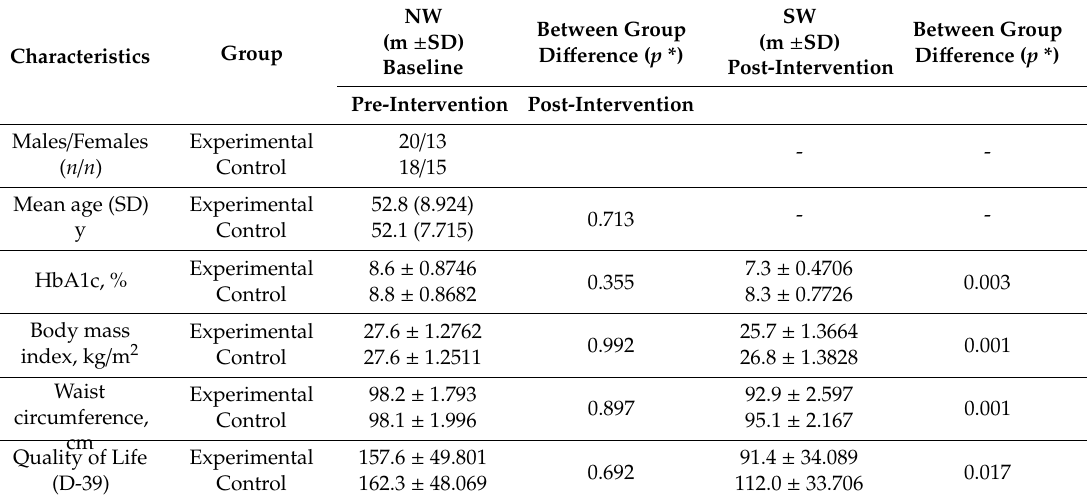
Table 1. Baseline and post-intervention mean di ff erence between variables.